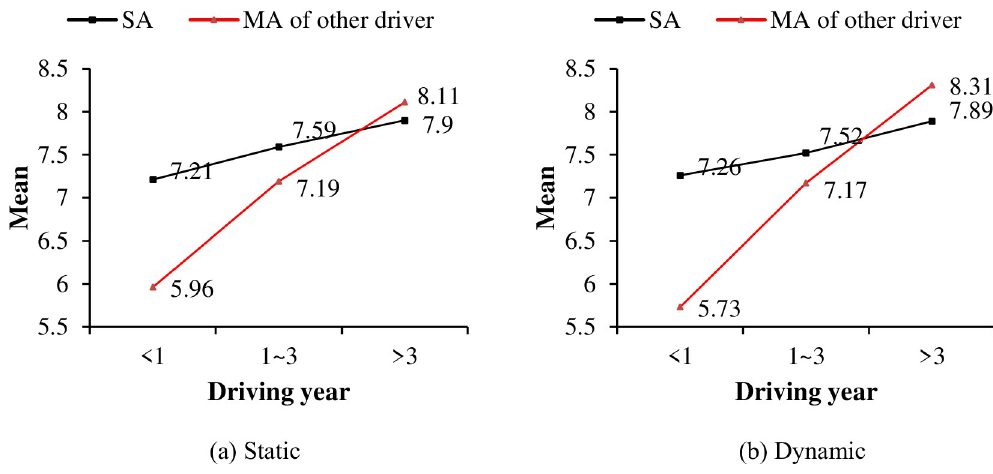
Fig 8. Comparisons of mean self-assessment and mutual-assessment score.